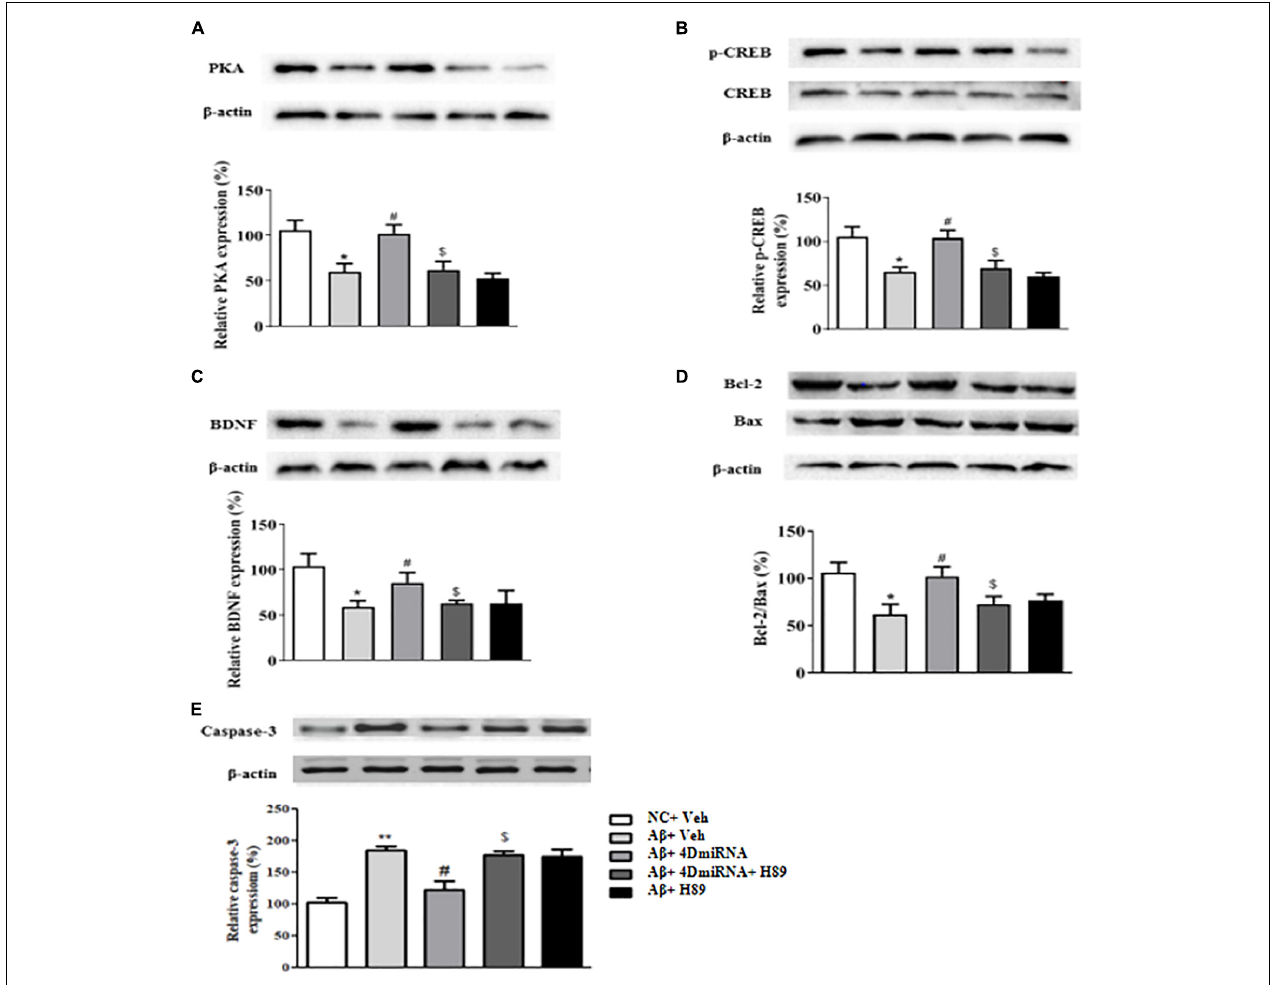
FIGURE 7 | PDE4D deficiency increased expression of PKA (A) , p-CREB (B) , BDNF (C) , Bcl-2/Bax (D) , and decreased caspase-3 (E) level in A β 1–42-treated mice. Results are expressed as mean ± SEM ( n = 12). * P < 0.05, ** P < 0.01 vs. control group (NC); # P < 0.05 vs. A β +Veh group; $ P < 0.05 vs. A β +4DmiRNA group.